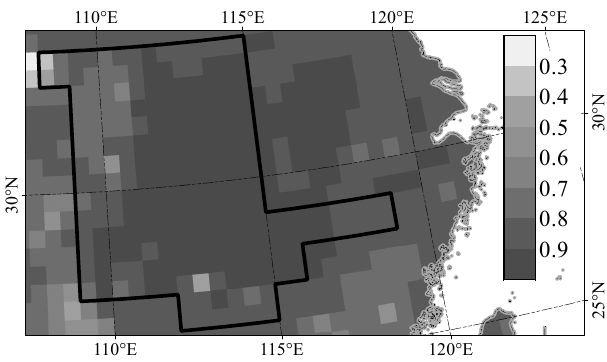
Figure 2. The spatial correlation between annual regional mean temperature series and each grid temperature in the study